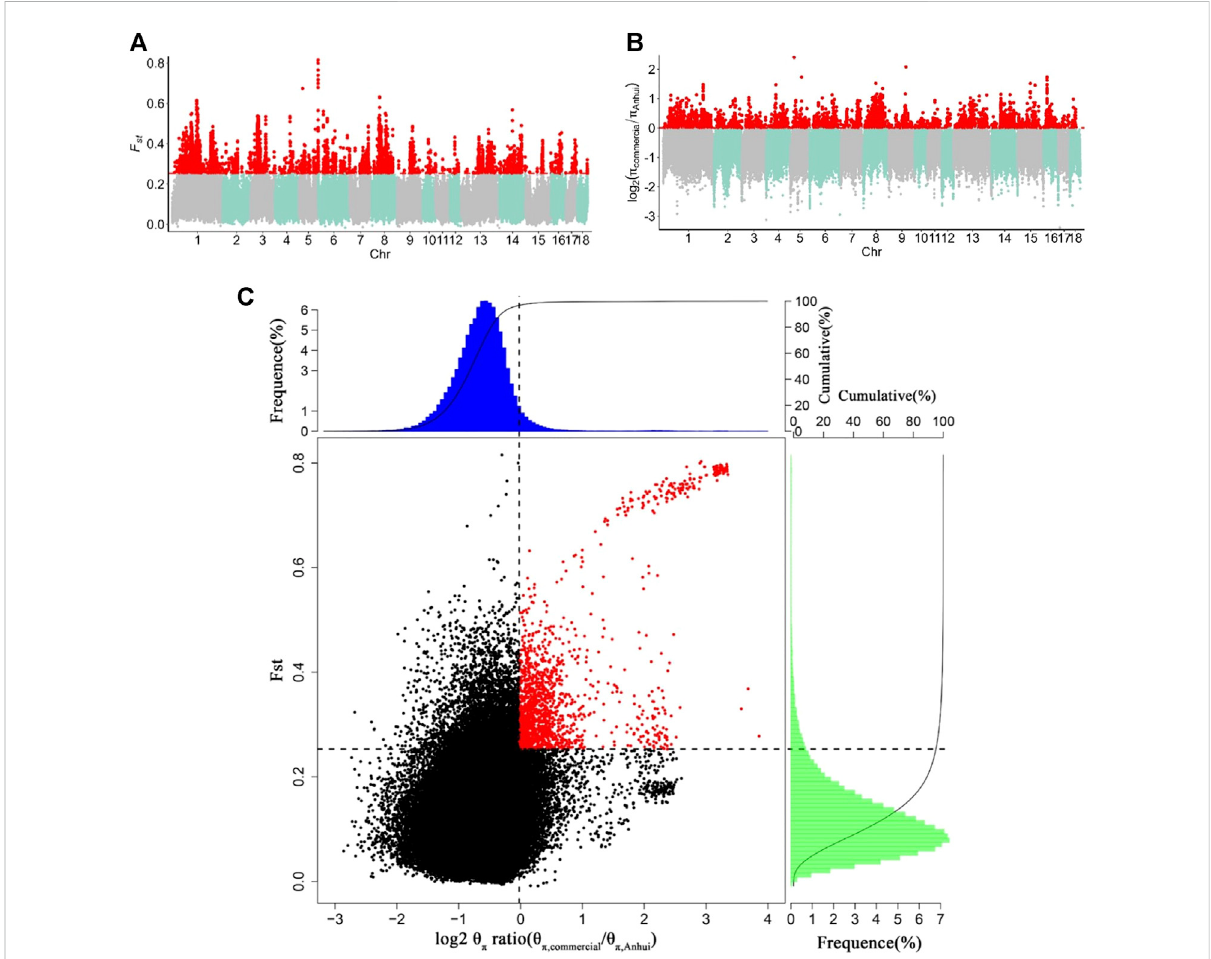
FIGURE 5 Identi fi cation of genomic regions with strong selective sweep signals between Anhui six pig population and four commercial pig population, which are calculated in a 40-kb sliding window approach with 20 kb step-size. (A) Distribution of F ST values among autosome chromosomes. The red line represents the 0.05 level. (B) Distribution of log 2 ( θπ ratio) among autosomal chromosomes. The red line represents the 0.05 level. (C) The fi nal selection regions based on two statistics. Points located to the right of the vertical dashed lines (corresponding to 5% right tails of the empirical log 2 ( θπ ratio) distribution, where log 2 ( θπ ratio) is 0.0.0011) and above the horizontal dashed line (5% above tail of the empirical FST distribution,whereFSTis0.2527)wereidenti fi edasselectedregionsforAnhuipigpopulation(redpoints).Thecommercialreferstofourcommercial pigs, the Anhui refer to Anhui pig